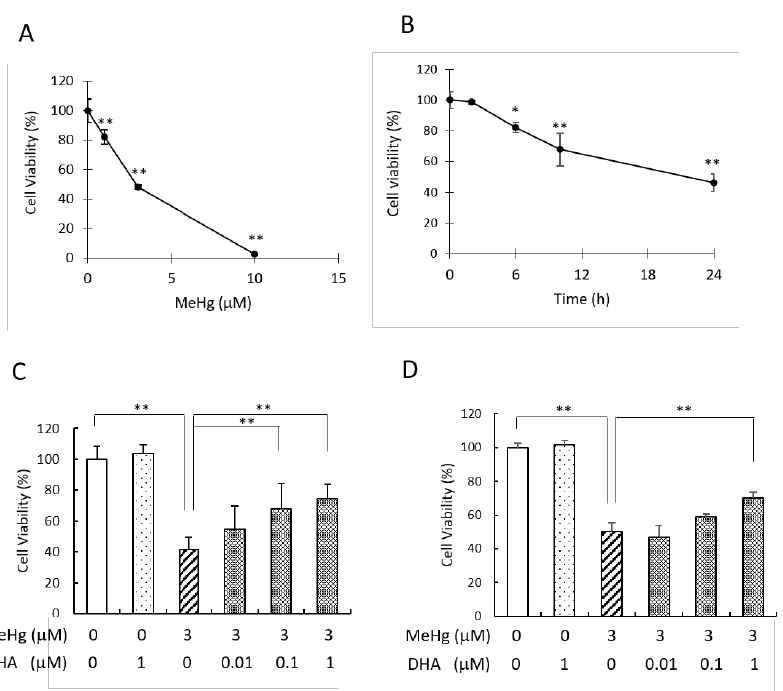
Figure 1. Pretreatment with DHA alleviated MeHg-induced cytotoxicity in SH-SY5Y and mouse primary neuronal cells. ( A ) SH-SY5Y cells were treated with MeHg at the concentrations of 1, 3, and 10 µM for 24 h, and cell viability was measured by MTT assay. ( B ) SH-SY5Y cells were treated with 3 µM MeHg for 2, 6, 10, and 24 h, and the cell viability was measured by MTT assay. SH-SY5Y cells ( C ) or mouse primary neuronal cells ( D ) were pretreated with DHA at the indicated concentration for 24 h, and then the cells were re-treated with DHA and 3 µM MeHg. After 24 h, the cell viability was measured by MTT assay. Values are the mean ± SD for four experiments. * p < 0.05; ** p < 0.01.